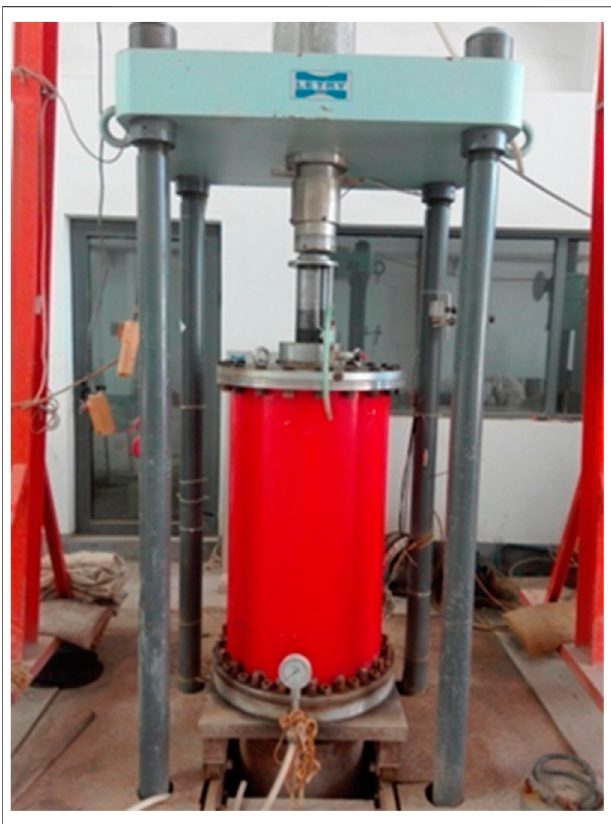
FIGURE 1 | Large-scale static triaxial